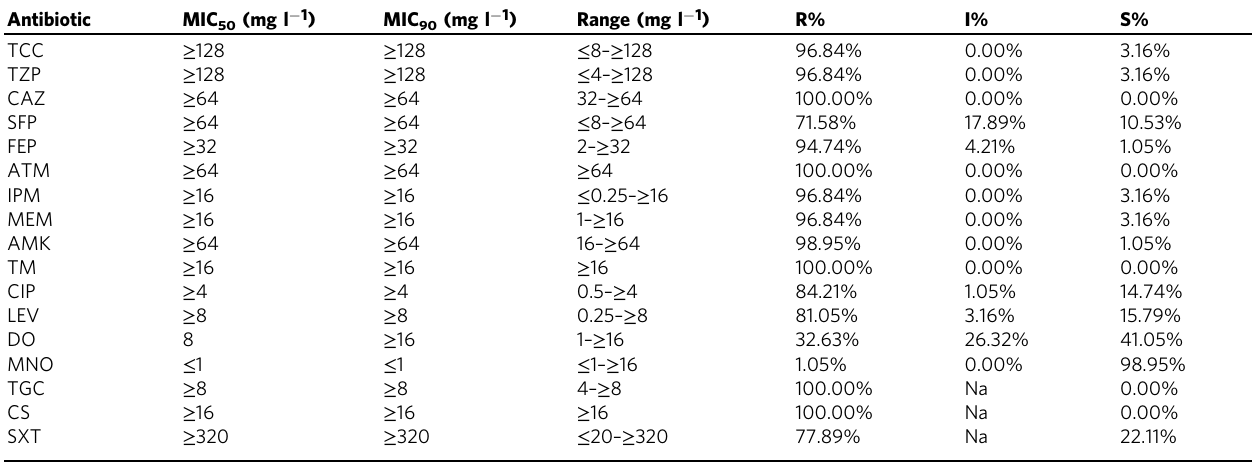
Table 3 Susceptibility of tet (X)-positive Flavobacteriaceae strains to commonly used antibiotics.